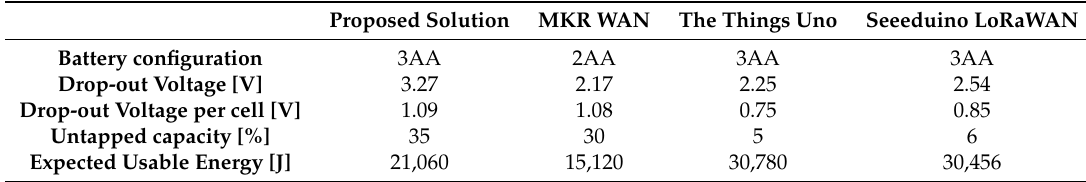
Table 3. Expected usable energy considered platforms.